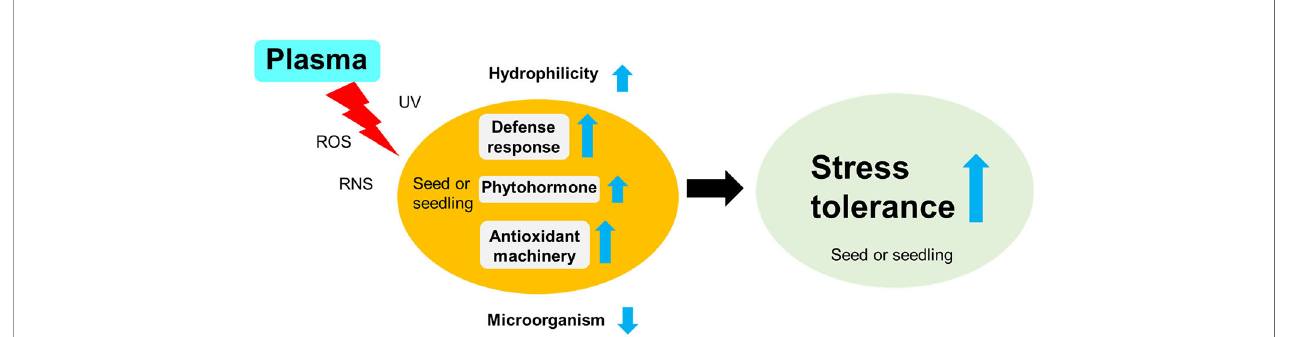
FIGURE 7 | The proposed mechanisms of the enhanced stress tolerance to environmental stressors in plasma-treated seeds (or seedlings). The plasma treatment (e.g., ROS, RNS, and UV) can enhance crop tolerance before a stress event by modulating the seed surface environment (e.g., hydrophilicity and pathogen inactivation) and physiological processes (e.g., enhanced antioxidant system and activated defense response) in the seed (or seedling).